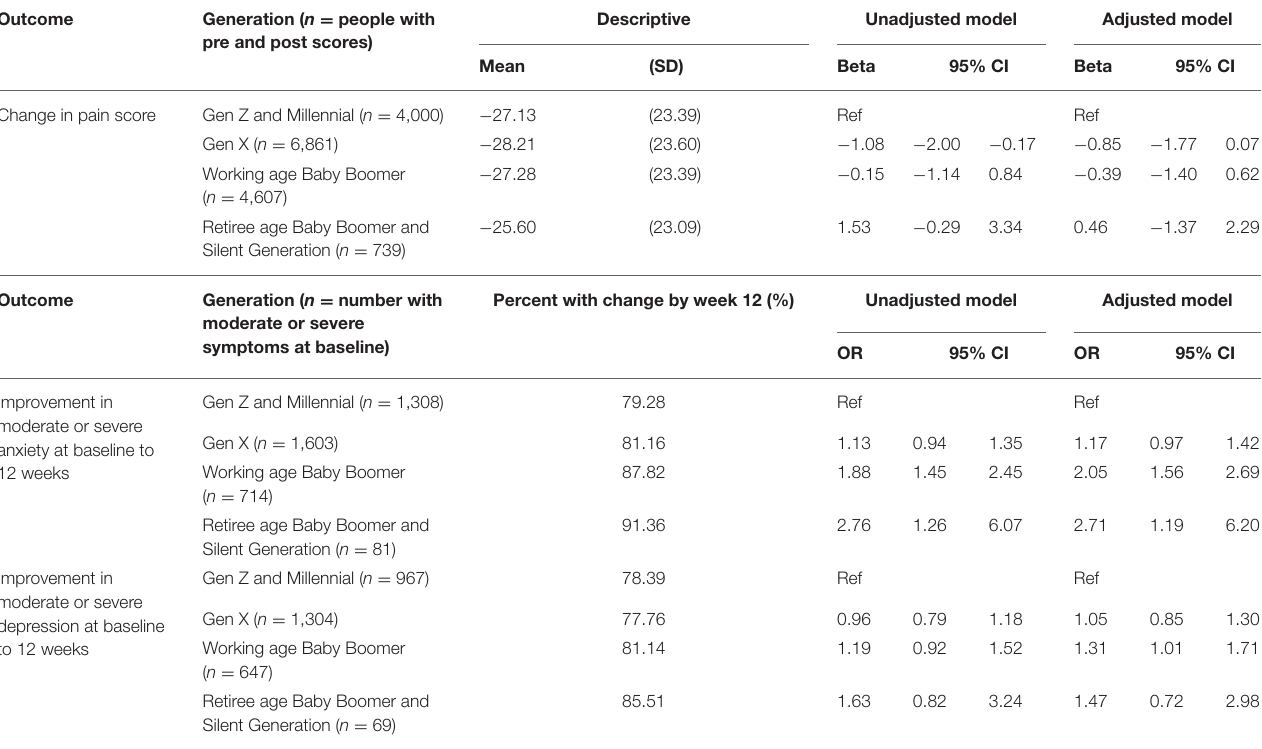
TABLE 4 | Change in clinical outcomes, by generation. Outcome Generation ( n = people with pre and post